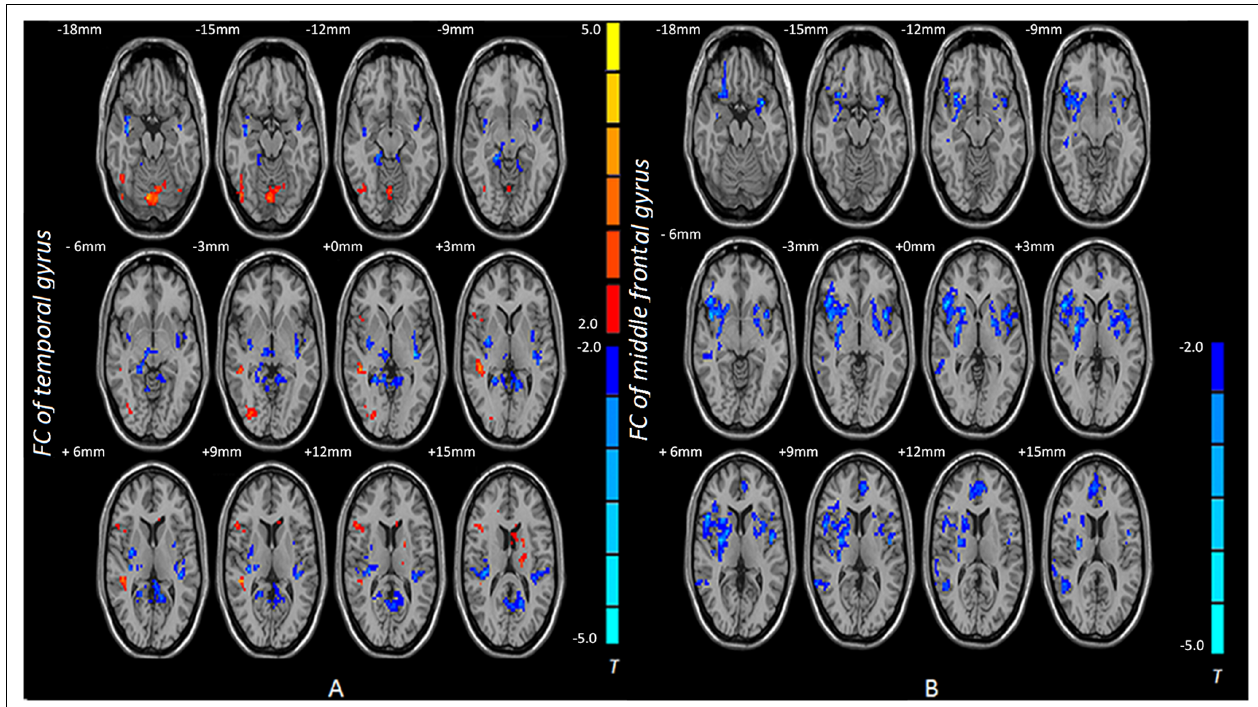
FIGURE 2 | Brain areas with increased and decreased FC in post-scan compared with pre-scan. (A) The voxels with hot colors represent increased FC between the temporal gyrus and the parietal lobe after training, and cold colors indicate that the temporal gyrus shows decreased FC with the parahippocampal cortex and the temporal gyrus after training. (B) The middle frontal gyrus exhibited decreased FC with the middle temporal gyrus and the middle frontal gyrus after training. Pair-sample t -test p < 0.05, AlphaSim corrected; FC, functional connectivity.